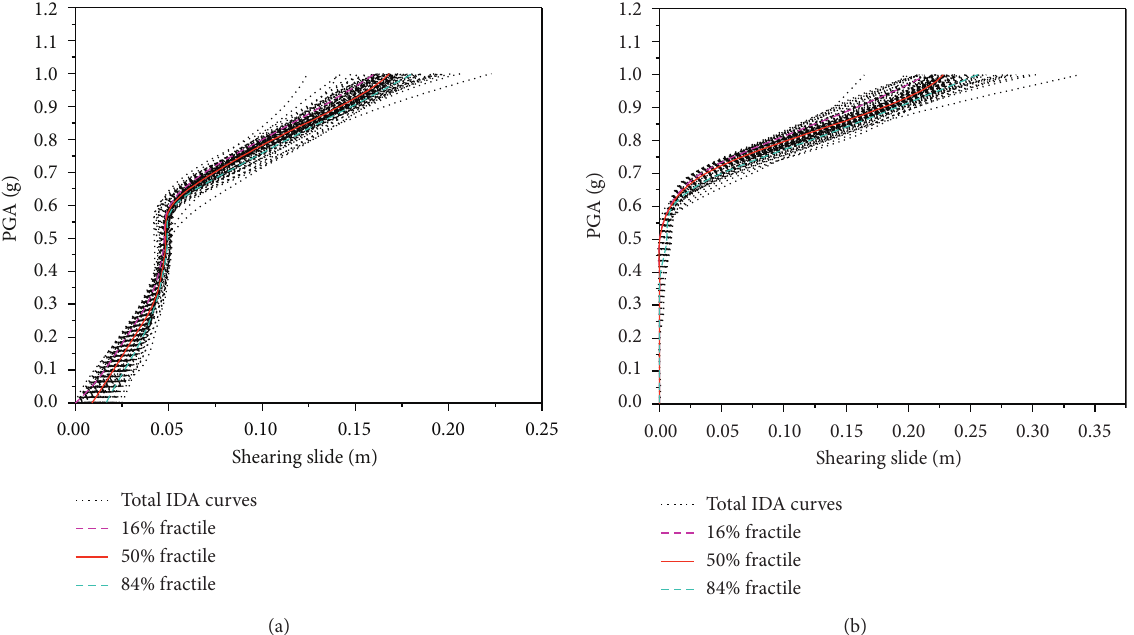
Figure 5: The total IDA curves with their 16%, 50%, and 84% fractile of dam samples of (a) the shearing slide of the starting point on the main sliding surface and (b) the shearing slide of the ending point on the auxiliary sliding